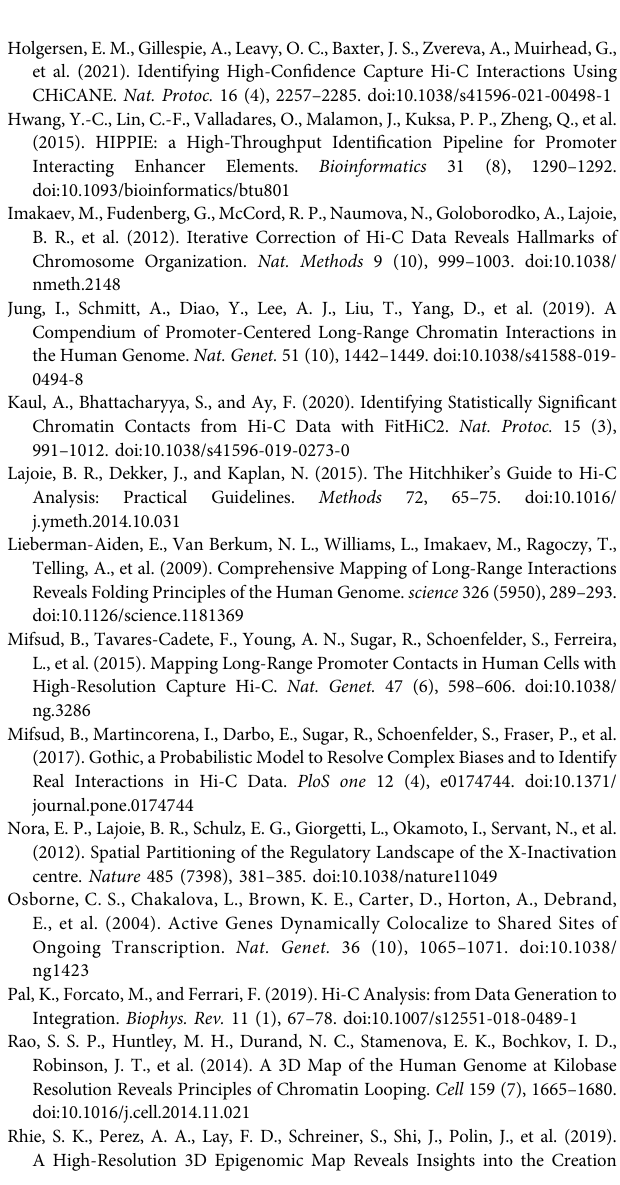
Supplementary Table S3 | Number of signi fi cant interactions identi fi ed (A) at the default thresholds (q < 0.05, CHiCAGO score > (cid:1) 5) and at stricter (B) q < 0.01, score > (cid:1) 10 or (C) q < 0.001, score > (cid:1) 15 thresholds. Supplementary Table S4 | Number ofbaits withat least one signi fi cantinteraction identi fi ed. Total number of baits used was 19,022 and 70,545 in HindIII- and MboI- digested samples, respectively. Supplementary Table S5 | (A-C) . Percentage of exact non-baited fragments detected at different signi fi cance thresholds that overlap in at least two replicates for each bait. (D) . Percentage of reproducible interactions, where the average q-value or CHiCAGO score of at least two replicates is below the default threshold. Supplementary Table S6 | Percentage of non-baited fragments detected at different signi fi cance thresholds, where both ends have been extended by 2.5 kb, that overlap in at least two replicates for each bait. Supplementary Table S7 | Percentage of non-baited fragments detected at different signi fi cance thresholds, where both ends have been extended by 20 kb, that overlap in at least two replicates for each bait.